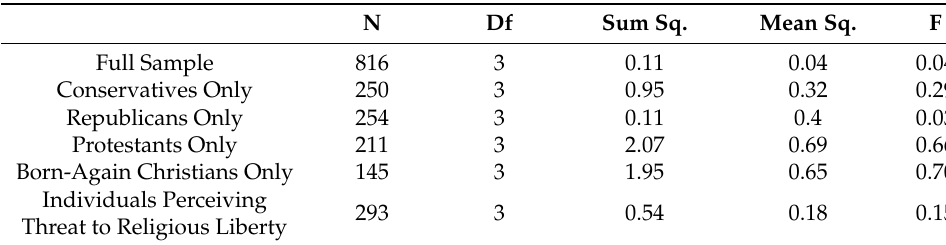
Table 6. Summary of experimental effects on support for political violence.